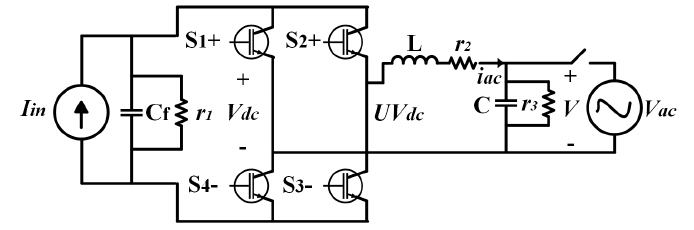
Figure 12. Typical VSI.